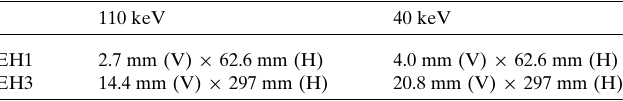
Table 4 Measured beam sizes of the 110 keV and 40 keV